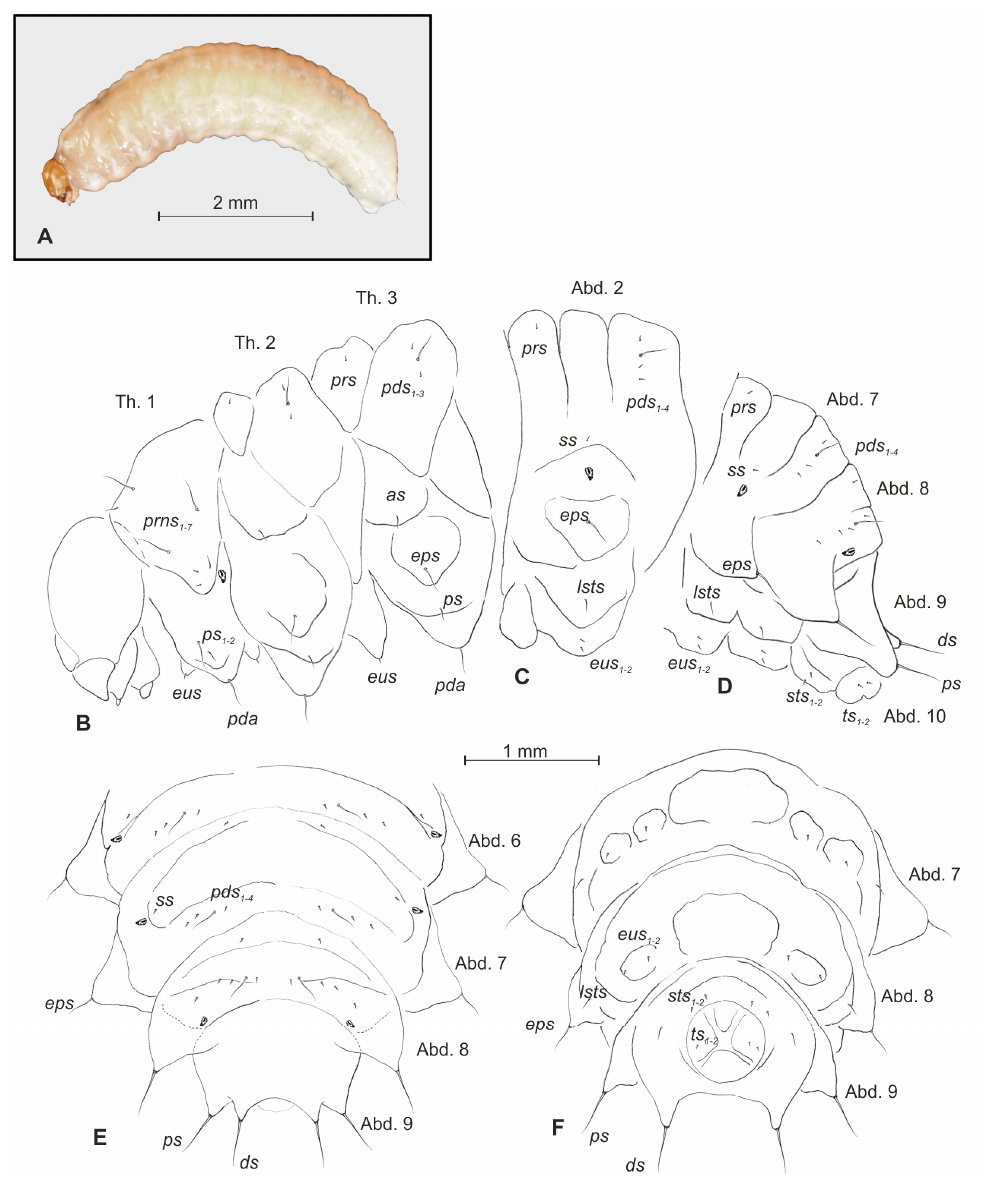
Figure 1. Bagous claudicans mature larva, habitus and chaetotaxy. ( A )—habitus; ( B )—lateral view of thoracic segments; ( C )—lateral view of second abdominal segment; ( D )—lateral view of the abdominal segments 7–10; ( E )—dorsal view of abdominal segments 6–10; ( F )—ventral view of abdominal segments 7–10 (Th. 1–3—thoracic segments 1–3, Abd. 1–10—abdominal segments 1–10, setae: as —alar, ps —